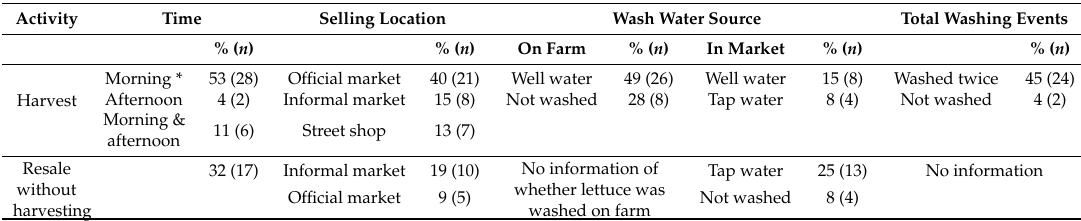
Table 1. Survey results about harvest time, sales location, washing practice, and water source of